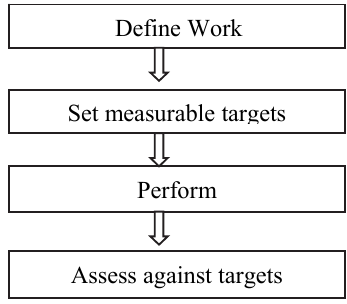
Figure 1: Performance control approach to appraisal